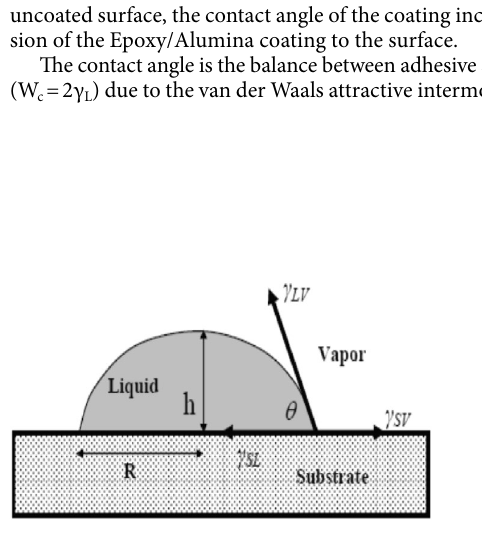
Figure 13. Principle of contact angle